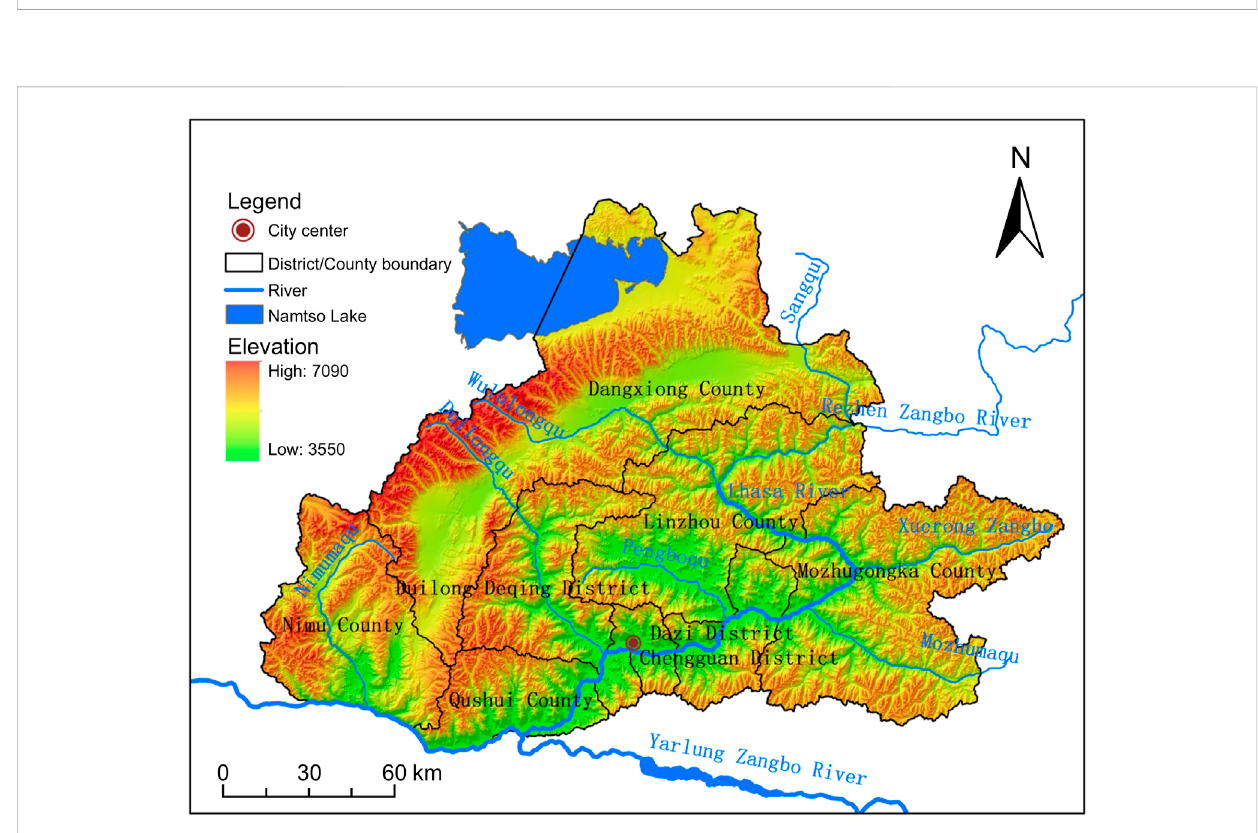
FIGURE 2 Topography and river system map of